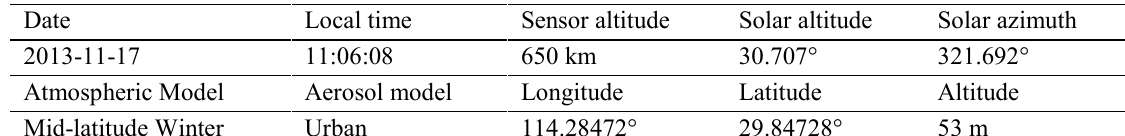
Table 2 Parameters of FLAASH atmospheric correction.